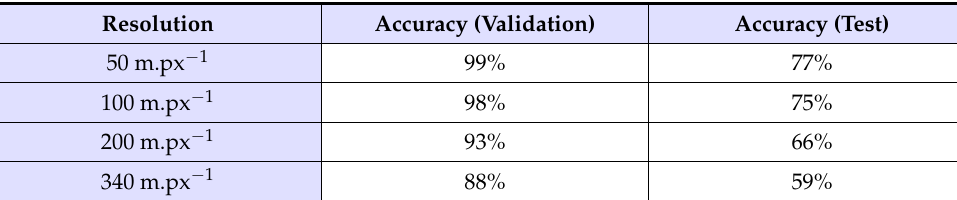
Table 1. Accuracy of the categorization task depending on the